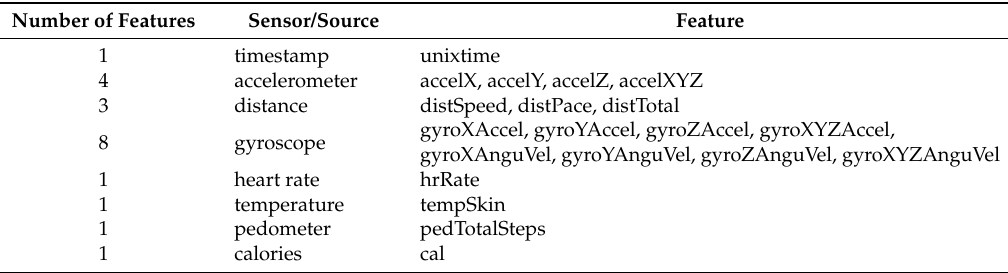
Table 1. Features for data